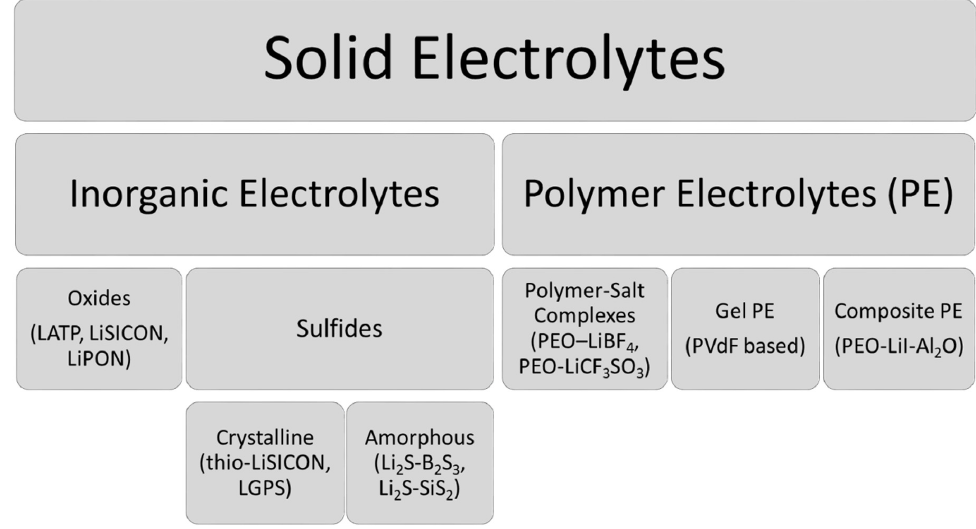
Figure 1. The most common solid electrolytes (SEs) and their examples [7,8]. Under inorganic electrolytes, Lithium SuperIonic CONductor (LiSICON) andderivatives are widely used as oxide-type electrolytes due to their lower reactivity with water and air. However, they show lower ionic conductivity at room temperature (RT) (~10 − 7 S cm − 1 ) compared to sulfide electrolytes [9]. In 1989, Aono et al. showed that Sodium (Na) SuperIonic CONductor (NaSICON)-type electrolytes such as Li 1+x Al x Ti 2 − x